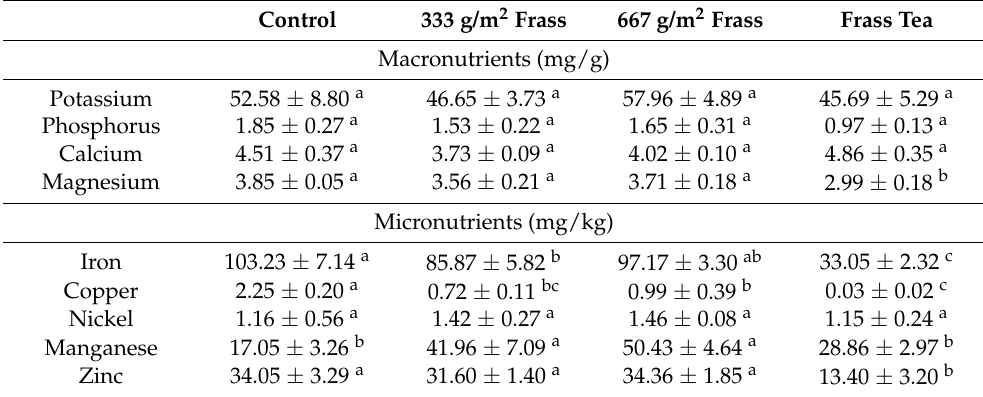
Table 4. Mean ( ± SE) mineral composition of sweetpotato slips after three weeks of being grown with black soldier fly ( Hermetia illucens ) larvae frass products or inorganic fertilizer.